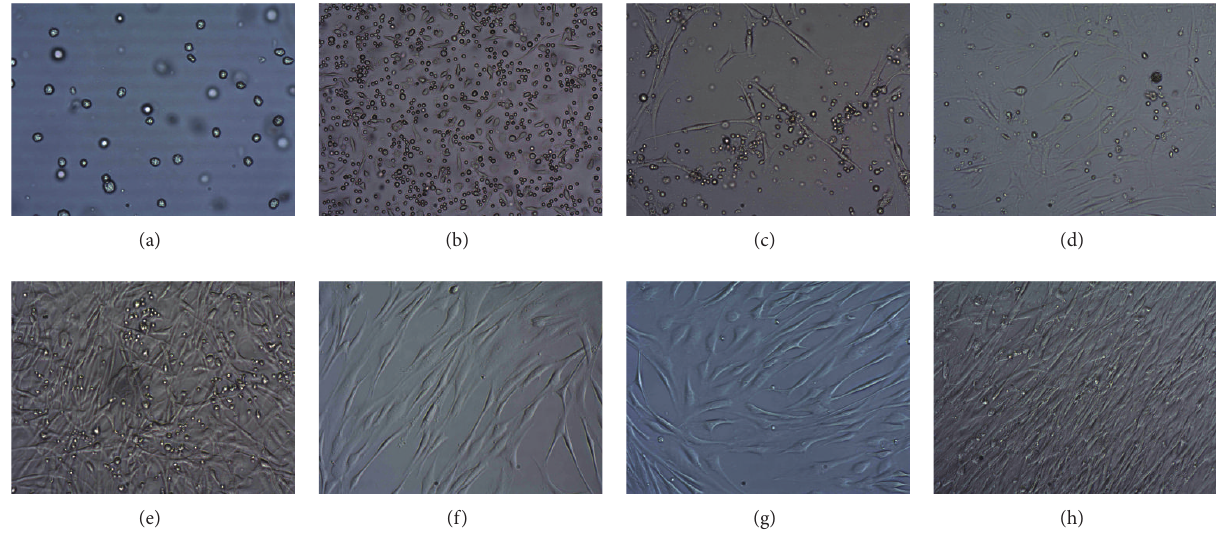
Figure 1: In vitro culture of autologous bone marrow mesenchymal stem cells. (a) Day 1 × 380 no staining; (b) Day 3 × 380 no staining; (c) Day 5 × 380 no staining; (d) Day 10 × 380 no staining; (e) Day 14 × 380 no staining; (f) Day 18 × 380 no staining; (g) Day 21 × 380 no staining; and (h) Day 26 × 380 no staining.